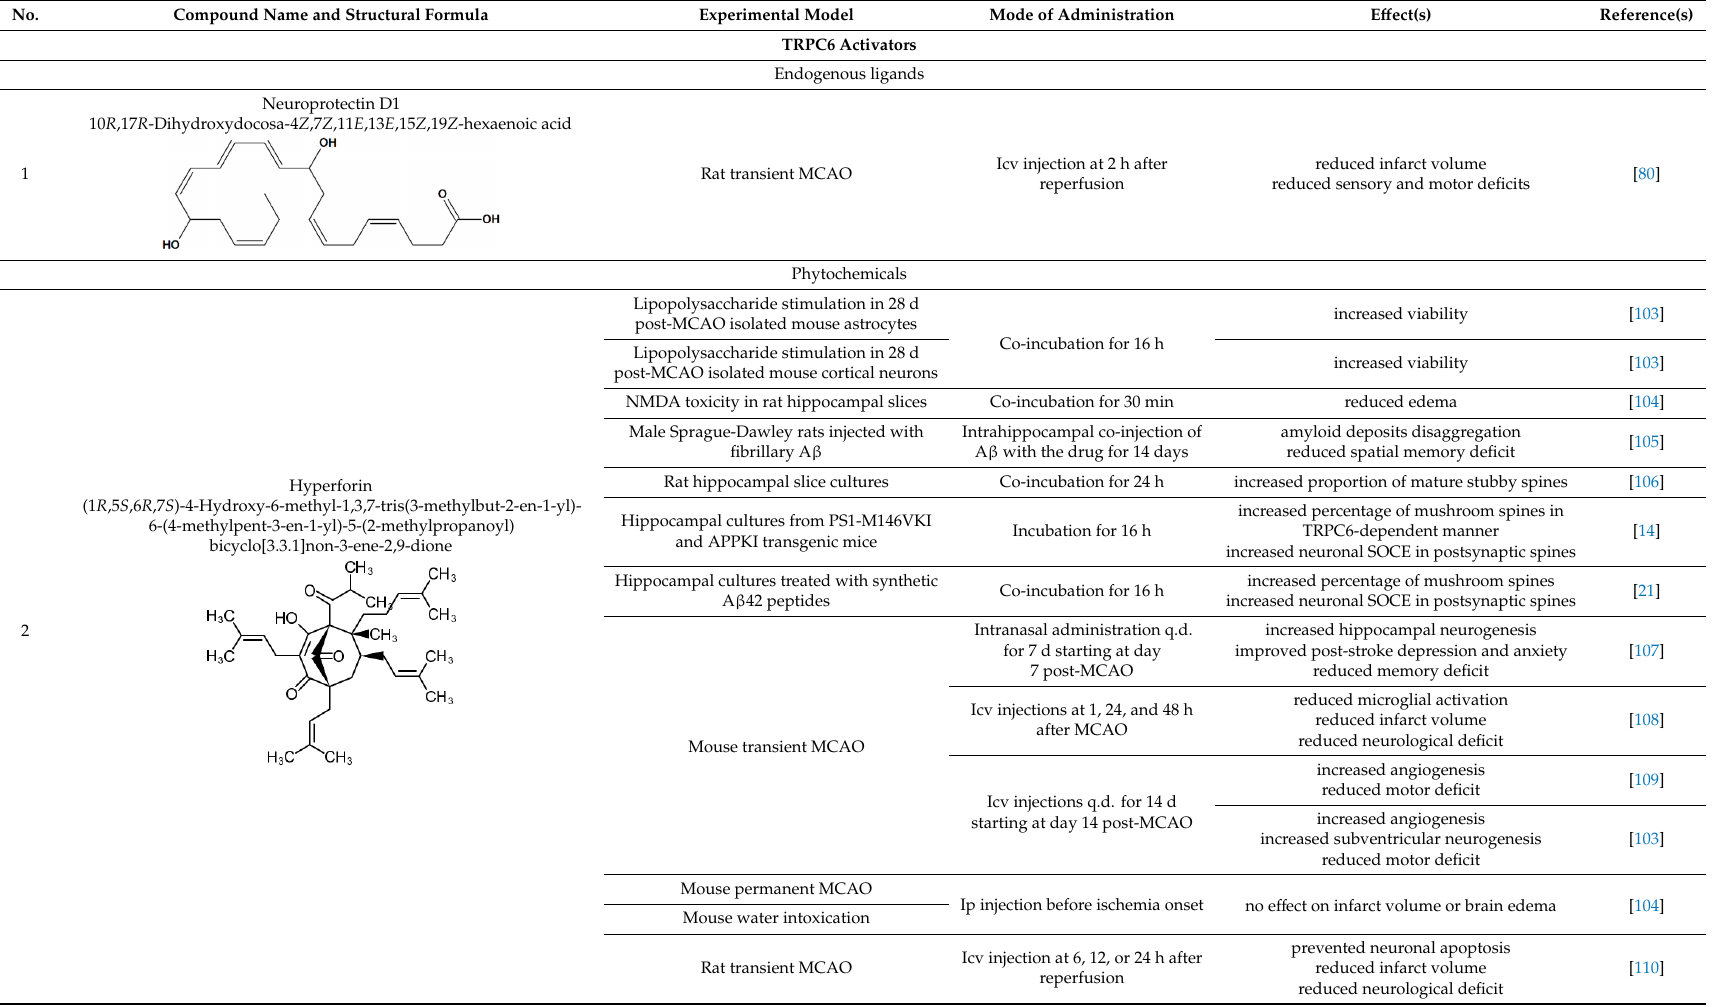
Table 1. Pharmacological modulators of TRPC6 in cerebral ischemia and AD